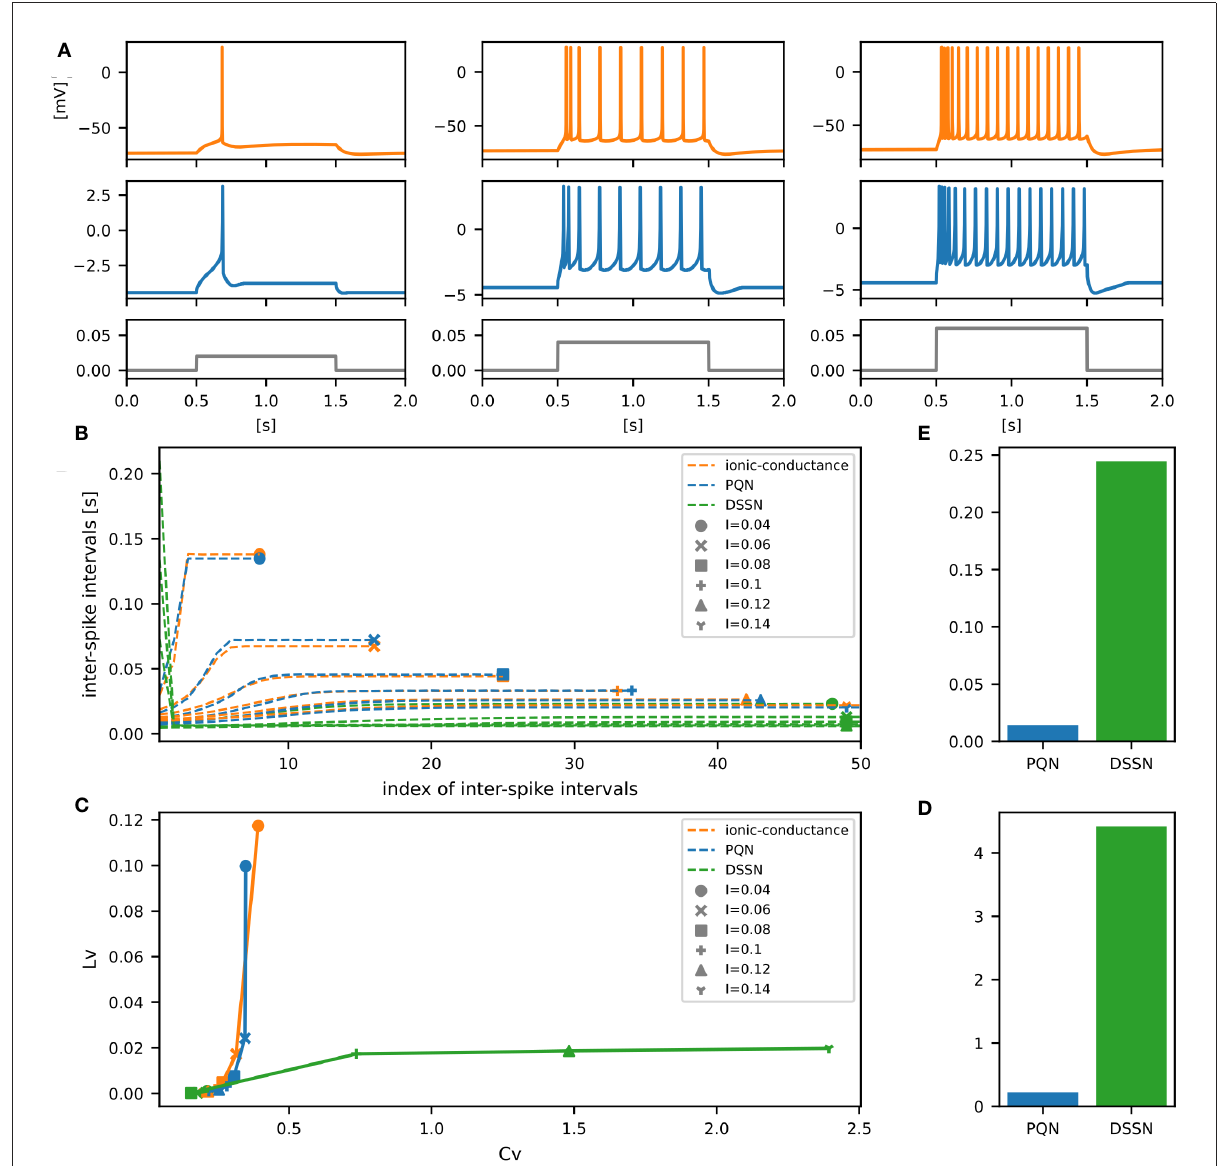
FIGURE7 Waveforms and spiking properties in inhibitory RS mode. (A) Waveforms of the ionic-conductance model (orange) and the PQN model (blue). Gray lines represent stimulus inputs. (B) The transitions of ISIs are shown while increasing the magnitude of the stimulus input. (C) The mean square errors of the PQN model and the DSSN model with the ionic-conductance model over the data points shown in (B) . (D) Values of the C V and L V were calculated from the waveforms and plotted while varying the magnitude of the stimulus inputs. The waveforms used here are the same as that used in (B) . (E) The mean square errors of the PQN model and the DSSN model with the ionic-conductance model over the data points shown in (D)